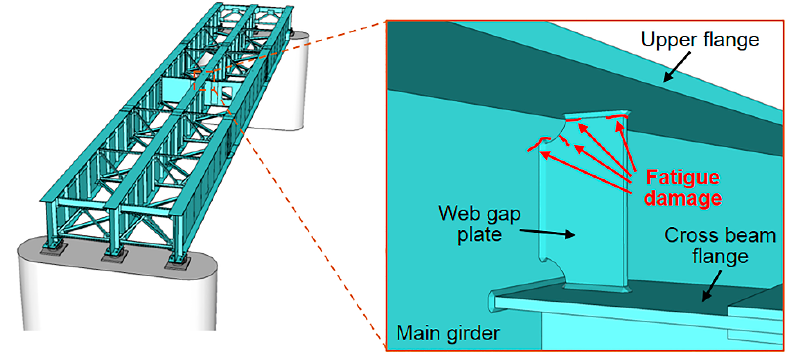
Figure 1. Example of fatigue damage at a steel bridge web gap plate.